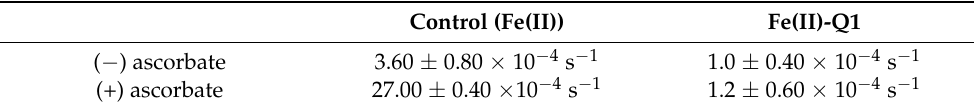
Figure 5. Kinetics of the initiation reaction of LA peroxidation in the absence and presence of the iron complexes of Q1 (see Materials and Methods for details), either: ( a ) without ascorbate, ( b ) with 2.5 mM ascorbate at 25 °C. Points-experiment, solid line-exponential fitting. Table 2. Rate constants for the initiation reaction of LA peroxidation in micelles induced by the Q1 iron complexes relative to the control (i.e., unchelated Fe(II) added as FeSO 4 ) in the presence and absence of ascorbate (2.5